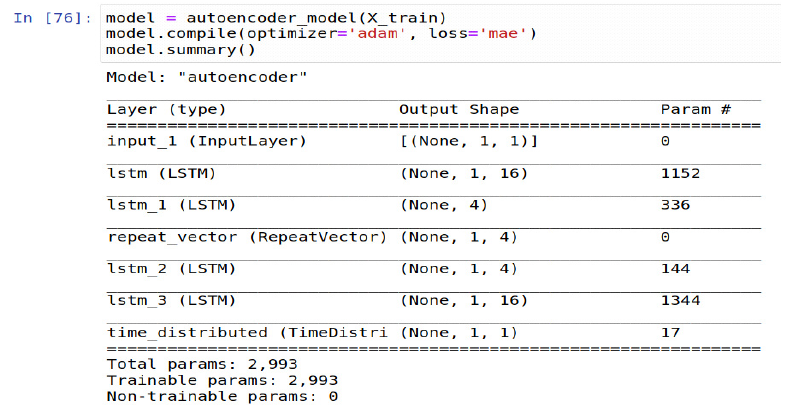
Figure 25. LSTM neural layers.